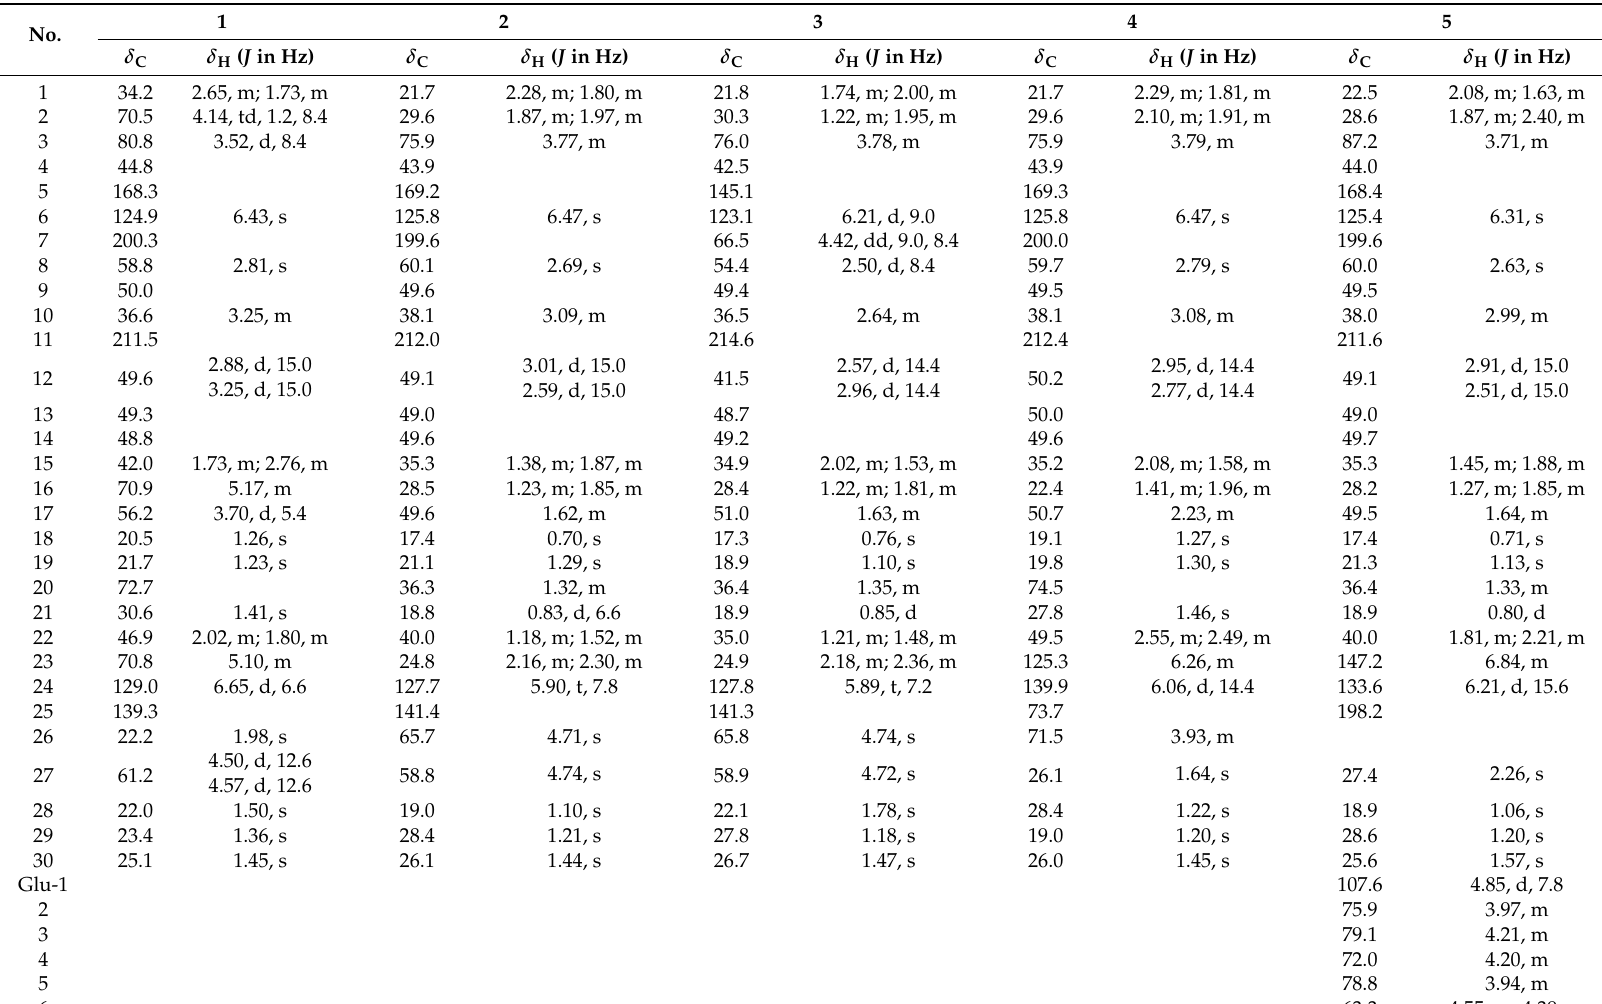
Table 1. NMR data of compounds 1 – 5 (Pyridine- d 5 , 600